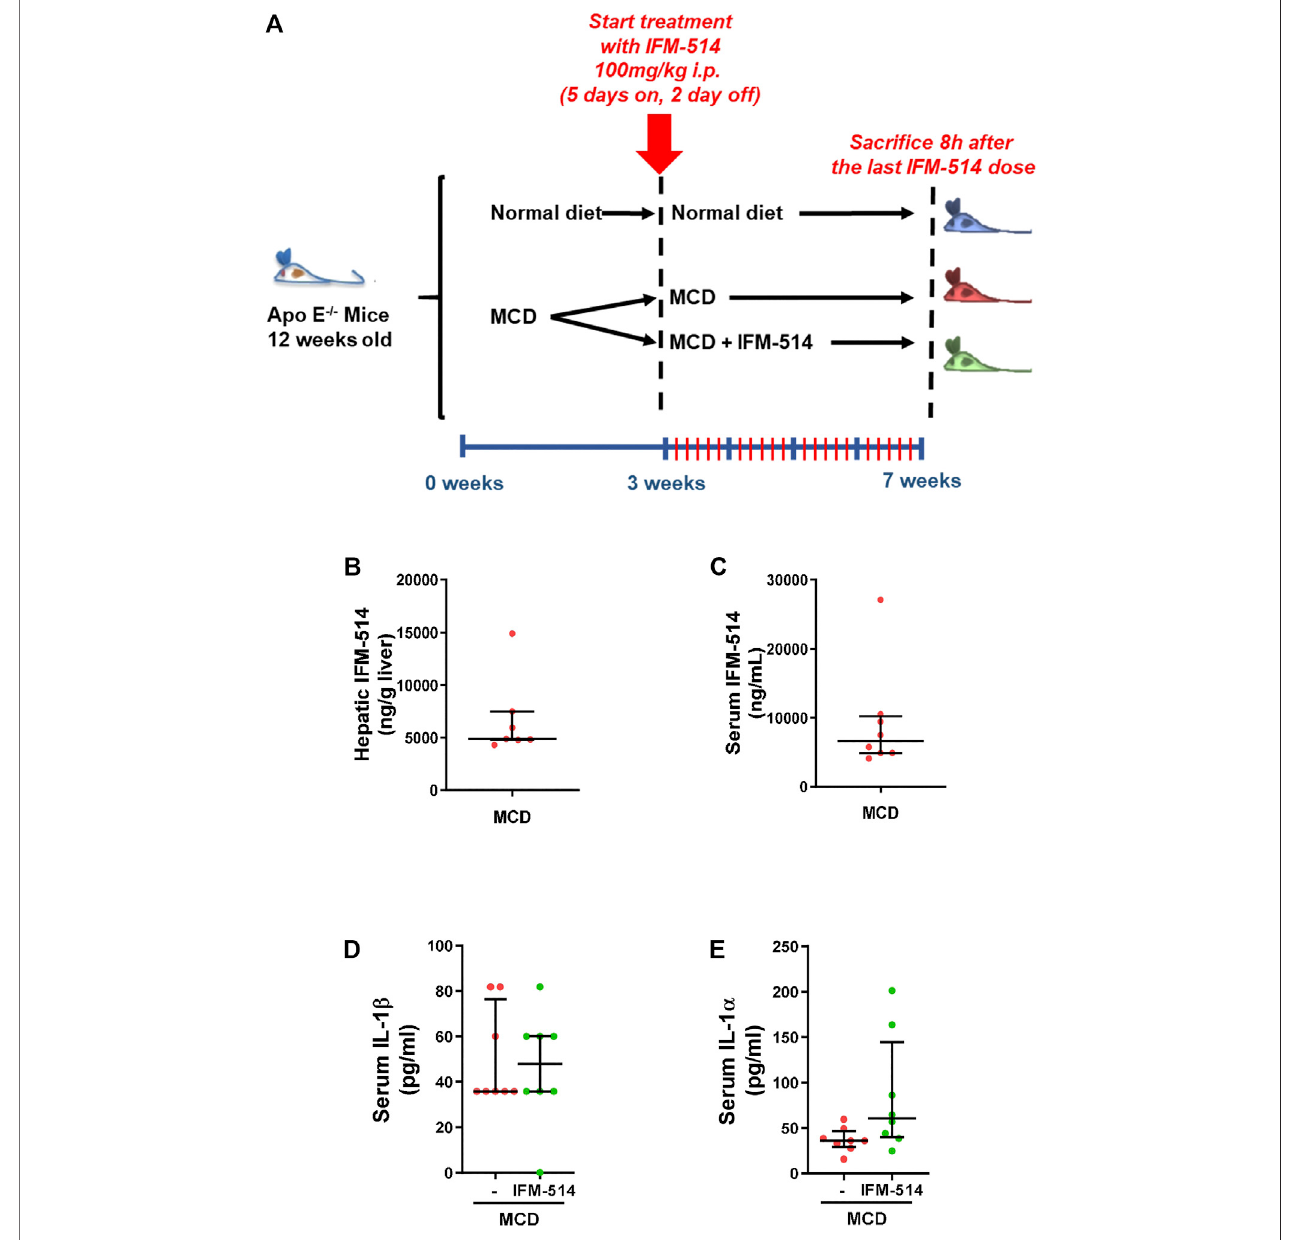
FIGURE 2 | Study design and interleukin levels. Groups (n (cid:1) 10) of 12-week-old ApoE -/- mice were fed ad lib for 7 weeks with methionine/choline de fi cient (MCD) diet. After 3 weeks of diet-induced injury, mice were injected i. p. with the NLRP3 antagonist IFM-514 (100 mg/kg body weight) or vehicle (0.5% carmellose) every day, 5 days/weekforafurther4 weeks (A) .ConcentrationofIFM-514inliver(ng/goftissue)andserum(ng/ml)followingi.p.administrationofIFM-514inNASH-inducedmice for 20 consecutive days. The concentration was measured by HPLC-MS (B – C) . Circulating IL-1 β and IL-1 α in IFM-514-treated MCD-fed ApoE -/- mice (D – E) . Results are expressed as mean ± standard error of the mean (SEM); n (cid:1) 10/group, * p < 0.05, ** p < 0.01 and *** p < 0.001. Abbreviations: IL1 α , interleukin 1 α .